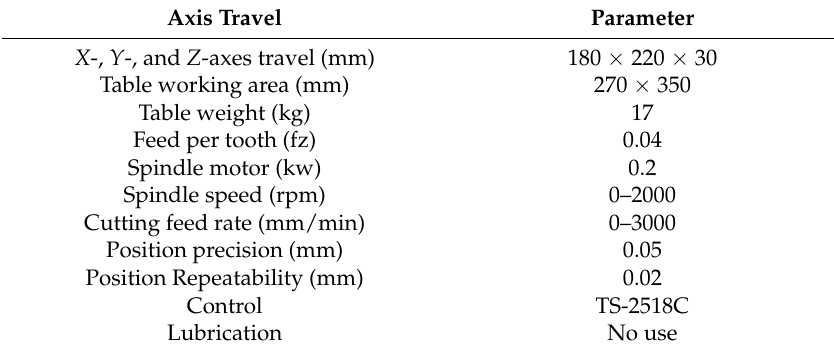
Table 1. Computerized numerical control (CNC) mini-engraving machine specifications.